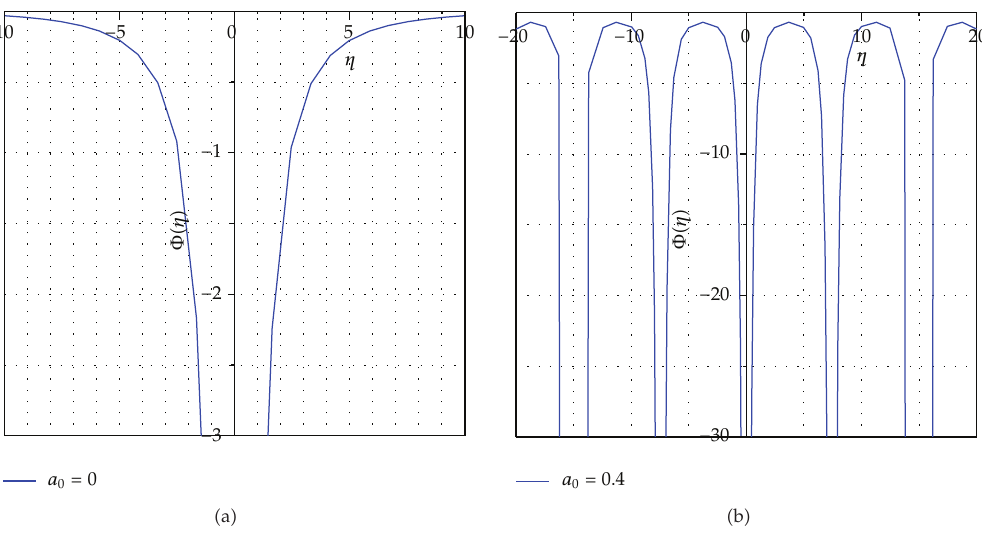
Figure 3: The explosive solution for expression (cid:2) 4.7 (cid:3) for v (cid:7) 0 . 04, σ (cid:7) 0 . 001, and γ 0 (cid:7) 0 . 01.